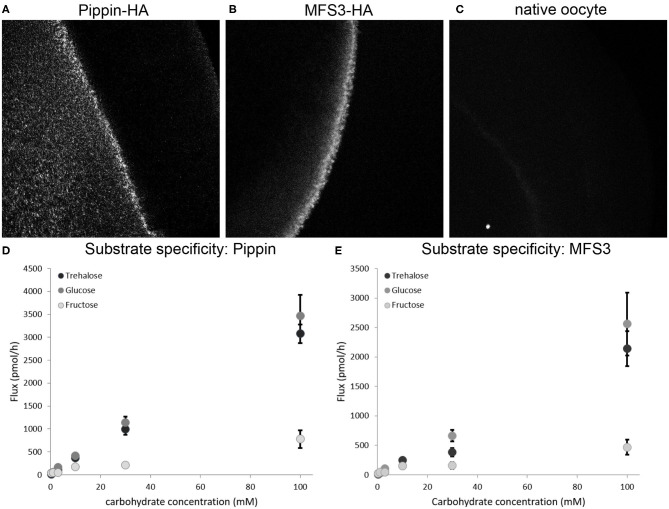
(A,B) Pippin and MFS3 facilitate carbohydrate transport. Heterologous expression of Pippin-HA and MFS3-HA in Xenopus oocytes (A) Pippin-HA (B) MFS3-HA are detectable on the surface of Xenopus oocytes (anti-HA immunostaining). (C) Native oocytes show no detectable HA staining. (D,E) Substrate specific uptake of 14C12-trehalose, 14C6-glucose and 14C6-fructose into Xenopus oocytes expressing (D) Pippin-HA or (E) MFS3-HA. Both Pippin and MFS3 show considerable transport capacity for trehalose and glucose, but not for fructose. Shown is the net-flux (flux observed in transporter-expressing oocytes minus flux observed in native oocytes). Values represent means ± standard error, N = 1–4.